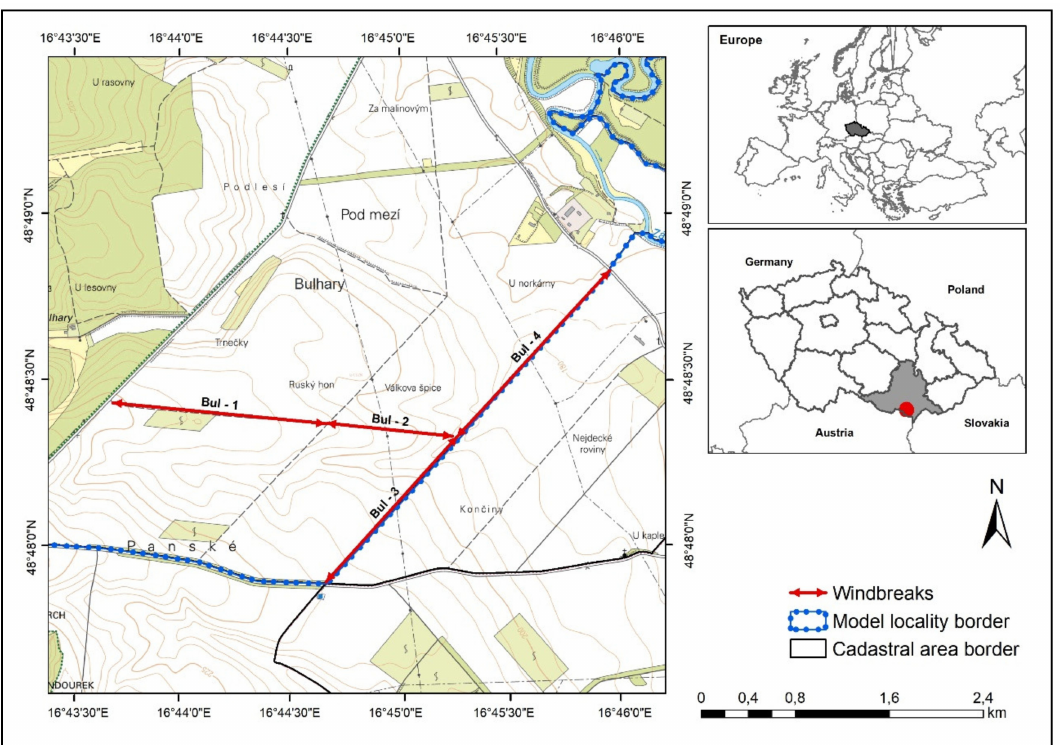
Figure 7. Study locality